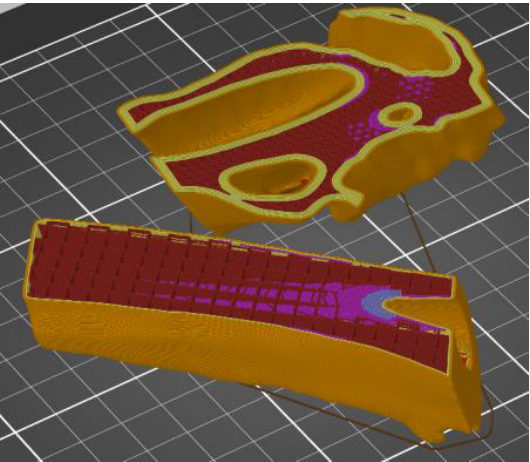
Figure 12. View of the anatomical model of the part of the bone in the working space of the software. For testing both solutions, 3D prints of the hip joint model with a part of the femur for Patient No. 7 were performed in two ways. The first one consisted of making a single bone cement model together with the pelvic bone (Figure 13a) and the upper part of the femur (Figure 13b).